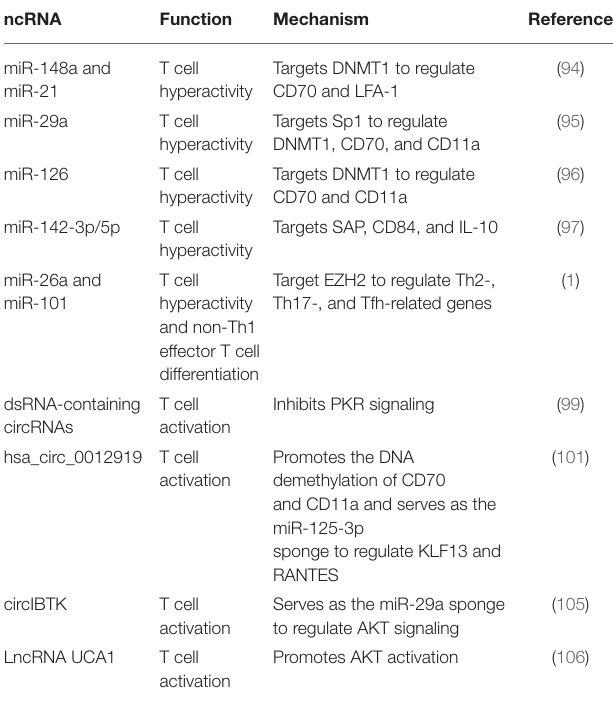
TABLE 7 | The roles of ncRNAs in the aberrant activation of CD4 + T cells in